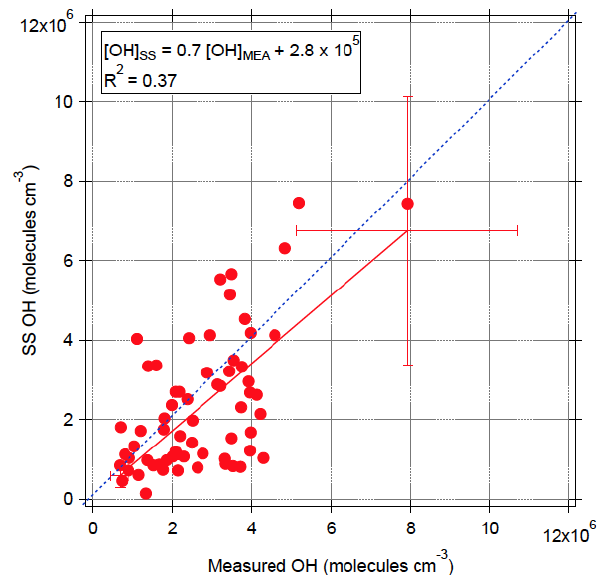
Fig. 4. A correlation plot with [OH] MEA and [OH] SS (red circles) and a 1:1 line (dashed line). The error bars on the regression line (red) represent uncertainties of [OH] MEA and [OH] SS